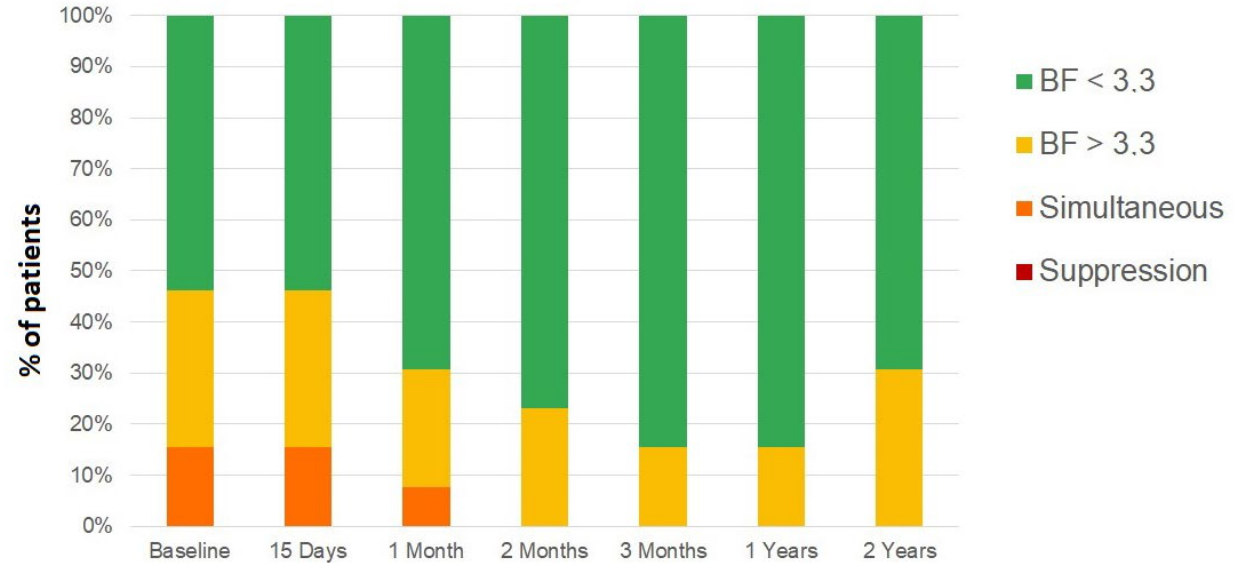
Figure 3. Binocular function (BF) score evolution of anisometropic amblyopia group from the previous visit to 15 days, 30 days, 60 days and 90 days of treatment, as well as at one and two years after completion of treatment.